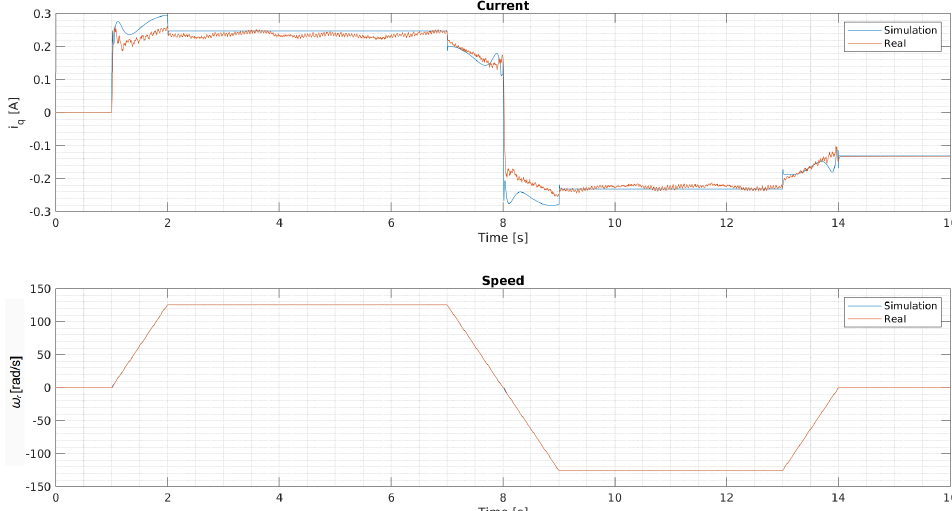
Figure 8. A comparison of the simulation and the real measurement of the actuator movement without load. The upper plot shows the waveforms of torque-generating currents; the bottom plot shows the angular velocity.